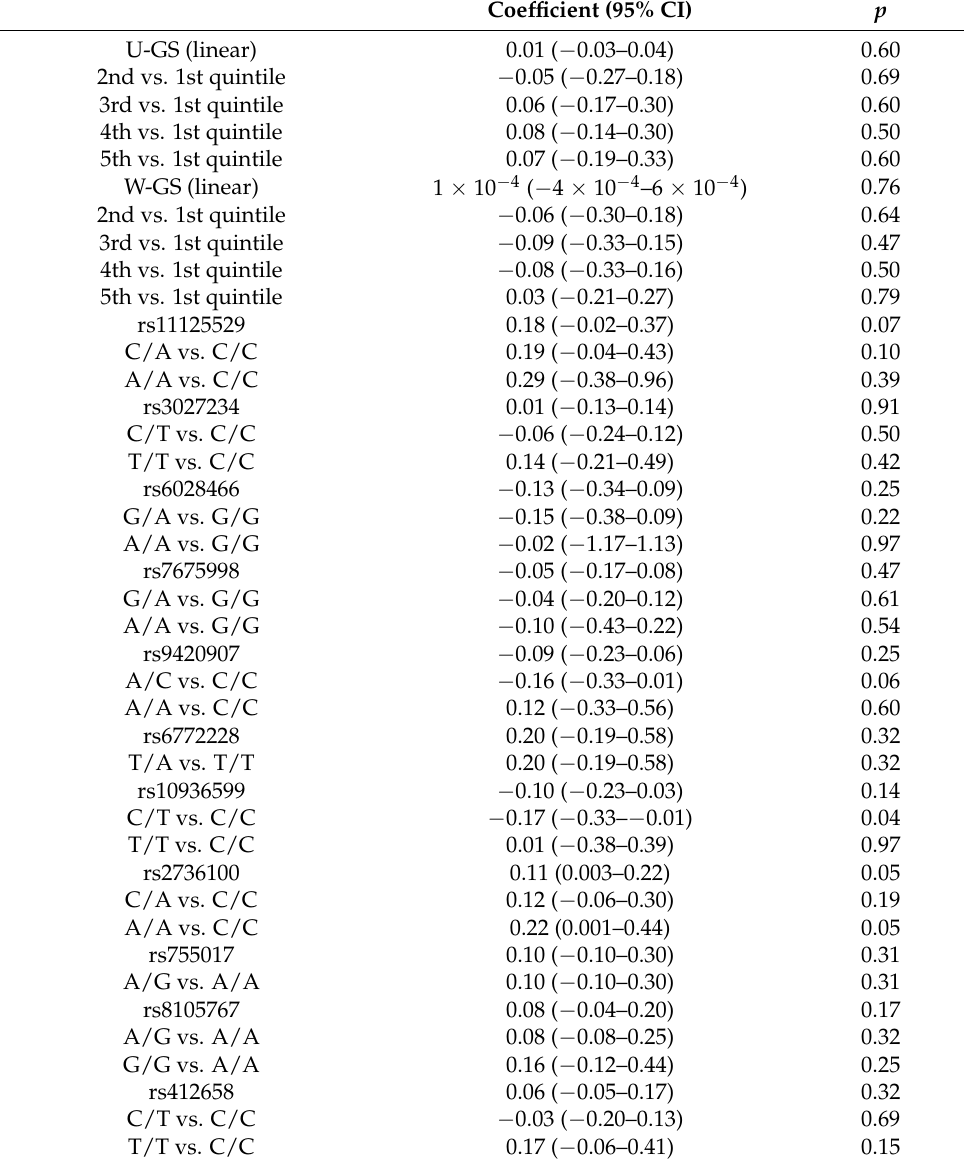
Table 4. Associations between the teloscore and the single nucleotide polymorphisms (SNPs) with log-transformed sperm telomere length